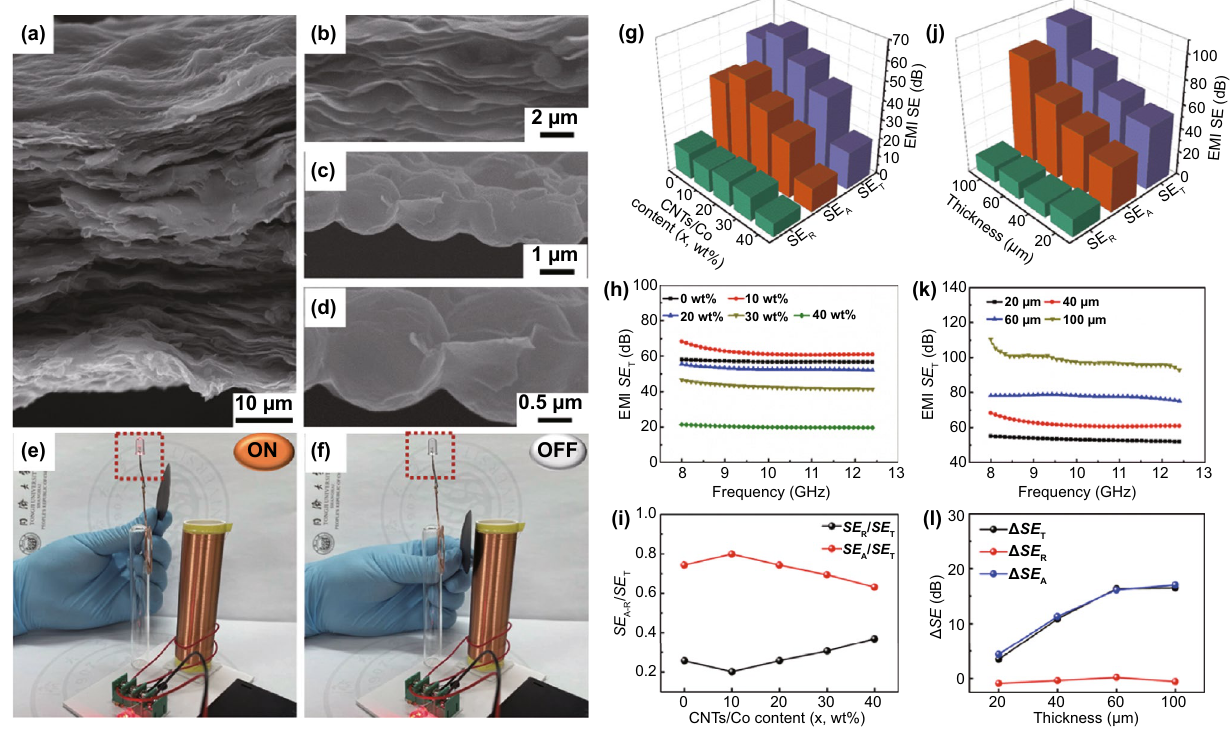
Fig. 4 Cross-sectional SEM image of Ti 3 C 2 T x /CNTs/Co film ( a–d ). The photograph of wireless power-transfer circuit without Ti 3 C 2 T x /CNTs/ Co film ( e ), LED on, and with Ti 3 C 2 T x /CNTs/Co film ( f ), LED off. ( g ) 3D histogram of average SE T , SE A , and SE R value, ( h ) average SE T , and ( i ) SE A / SE T and SE R / SE T ratio of 40-μm-thick Ti 3 C 2 T x /CNTs/Co nanocomposites with different contents of CNTs/Co. ( j ) 3D histogram of aver- age SE T , SE A , and SE R value, ( k ) average SE T of Ti 3 C 2 T x /CNTs/Co (10 wt%) nanocomposites with different thicknesses, and ( l ) comparison of EMI Δ SE T , Δ SE A , and Δ SE R value versus thickness of Ti 3 C 2 T x /CNTs/Co (10 wt%) and Ti 3 C 2 T x